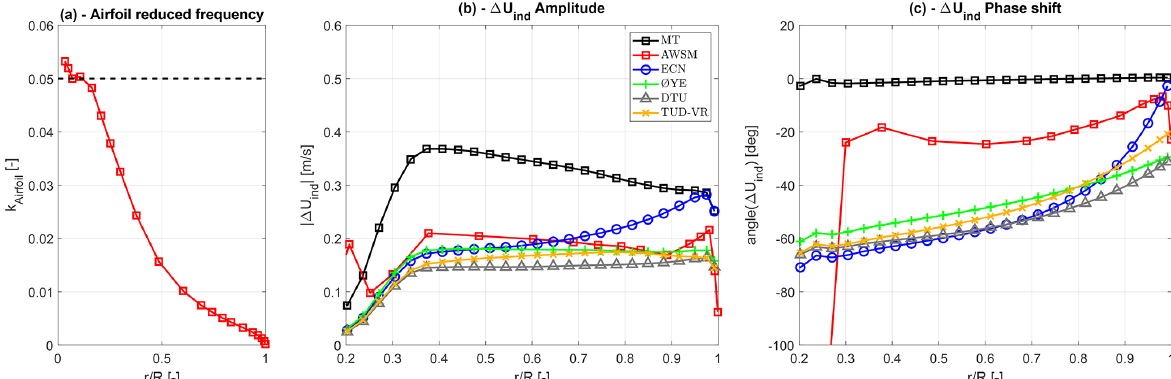
Figure 8. Spanwise distributions for the 50mHz sinusoidal pitch variation above rated conditions (a) of the reduced airfoil frequency; (b) of the axial induced-velocity variation amplitude at the blade pitch frequency; and (c) of the axial induced-velocity variation phase at the blade pitch frequency, with respect to the phase of the prescribed pitch time